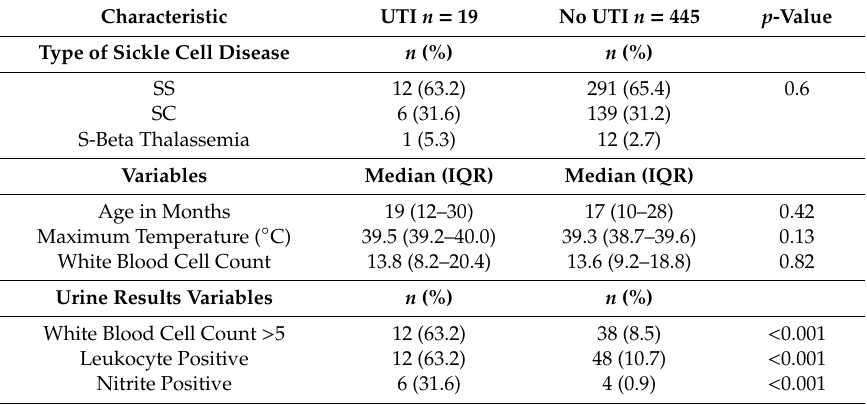
Table 2. Characteristics of patients with and without urinary tract infection